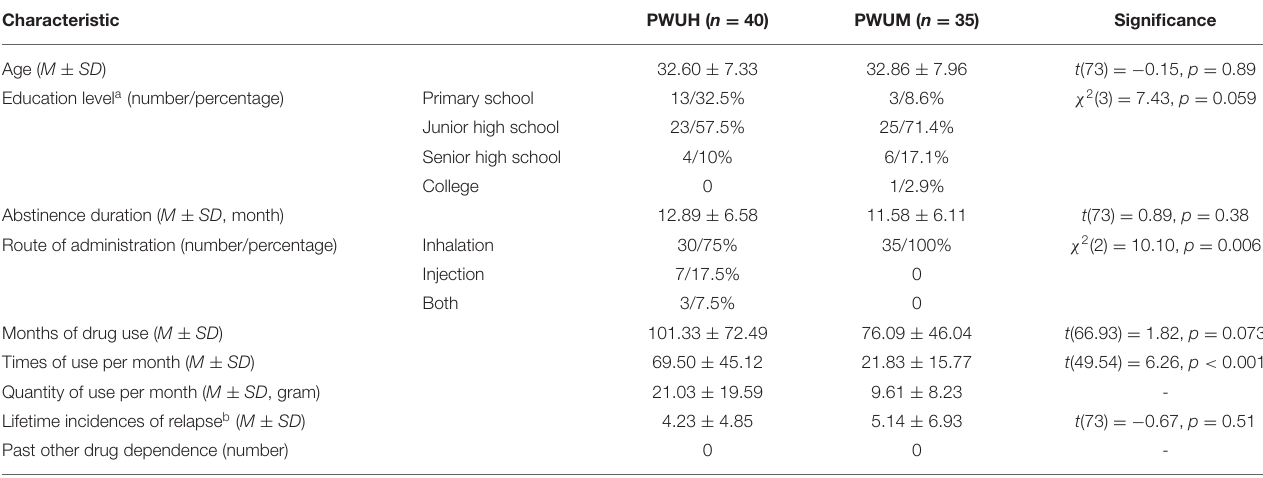
TABLE 1 | Demographic characteristics of and differences between people who used heroin (PWUH) and people who used methamphetamine (PWUM).